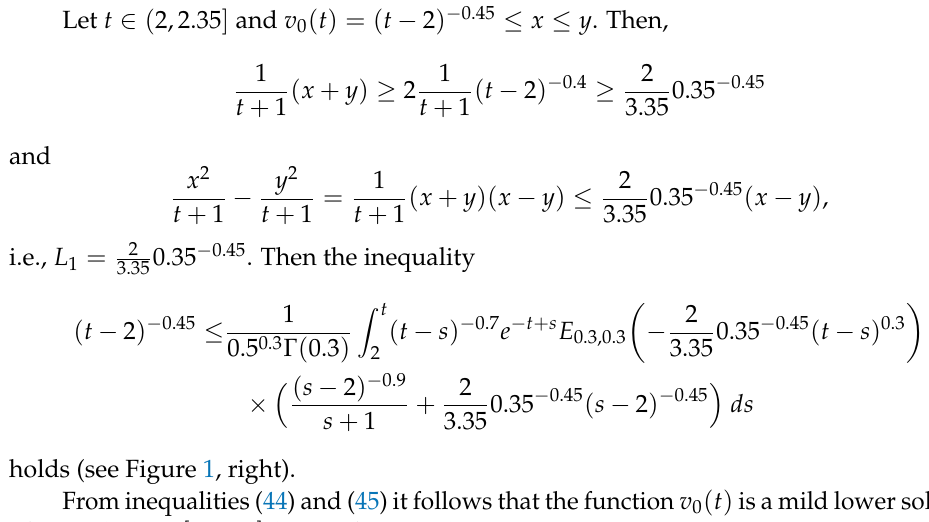
Figure 1. Graphs of v 0 ( t ) = t − 0.4 and the integral in (44) with t ( t 2 ) − 0.45 and the integral (45) with t − −